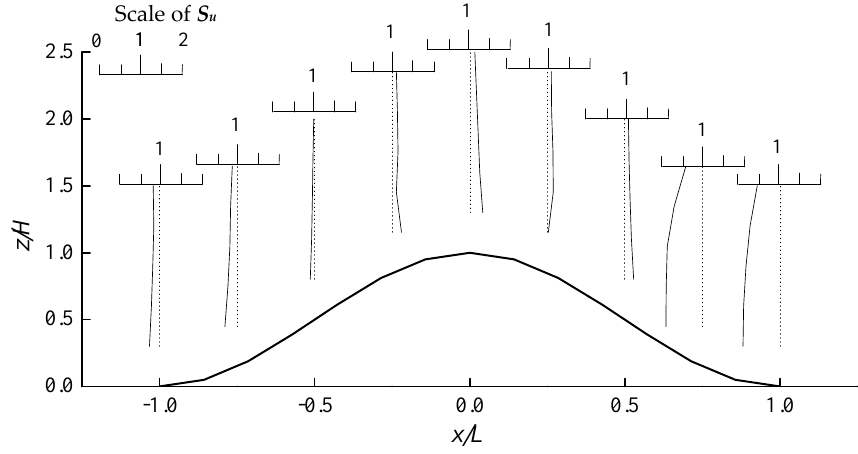
Figure 6. The streamwise mean wind speed-up S u on the along-wind center line of the hill ( y = 0).